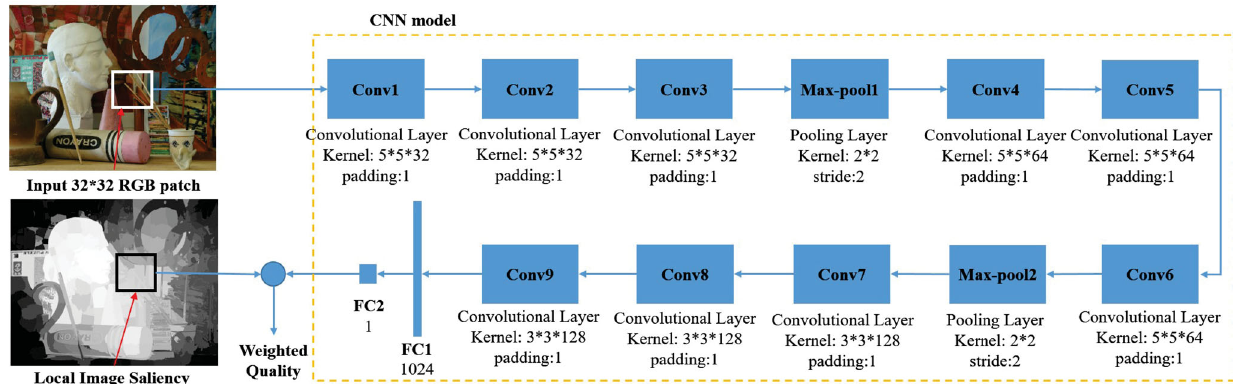
Fig. 2 Architecture of our no-reference synthetic image quality metric. The inputs are small (32 × 32) patches. The predicted patch scores are weighted by local image saliency.